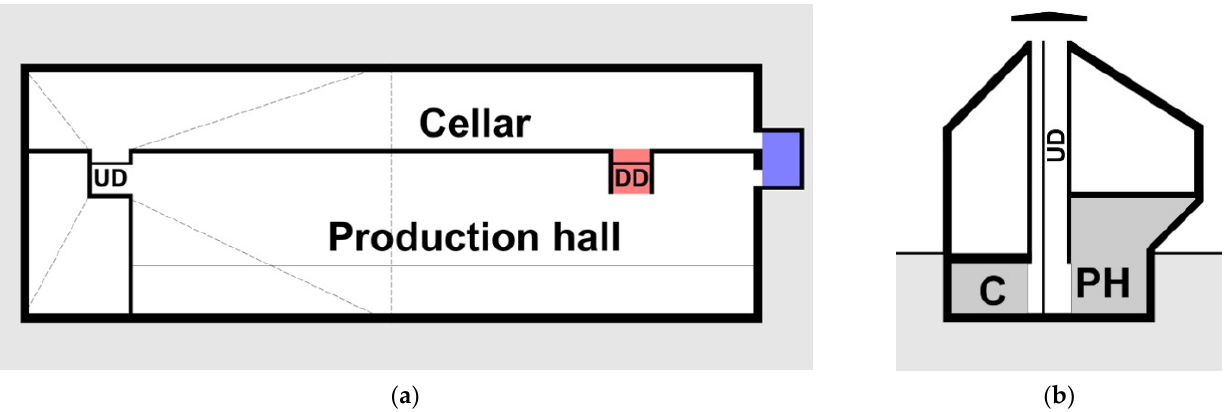
Figure 6. ( a ) Floor plan, red shows the DD inlet tower, existing only in the DD PACS version; blue shows the ground zone inlet, existing only in UD PACS; ( b ) Section of the natural ventilated spaces